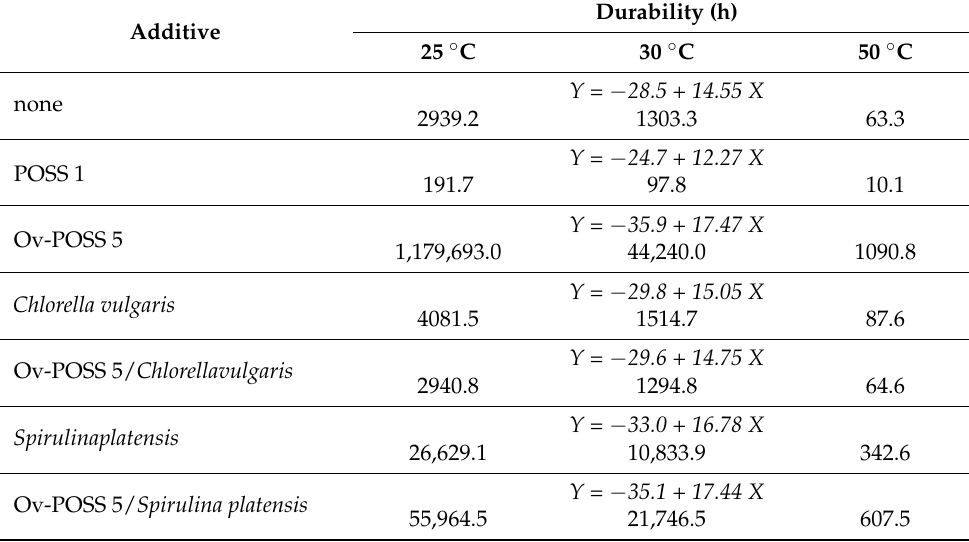
Table 3. Durability of EPDM to the thermal degradational at low temperatures.